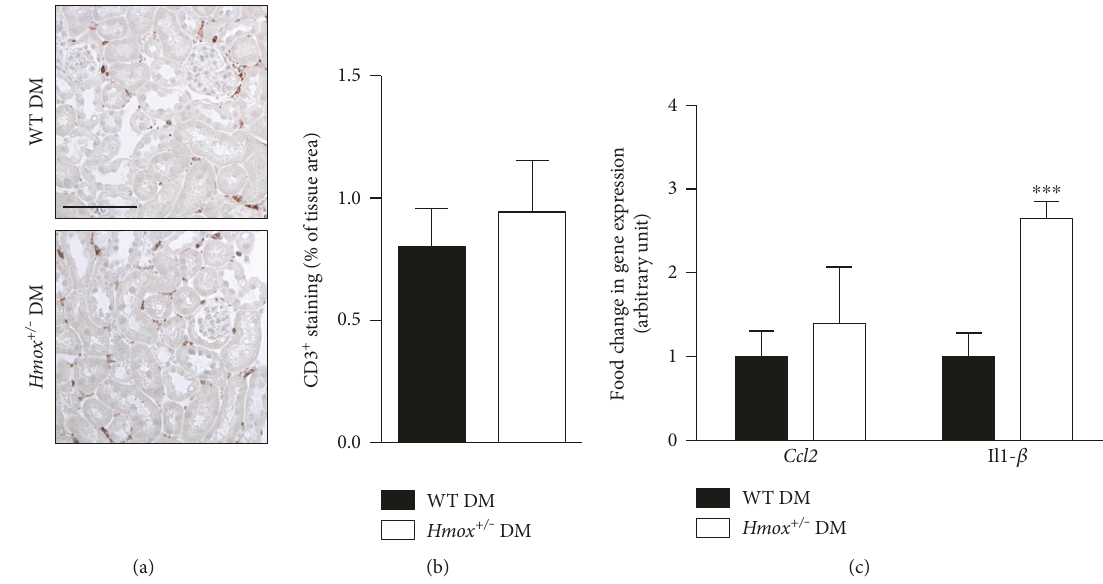
Figure 3: HO-1 does not modulate renal in fl ammatory cell in fi ltration in STZ-induced diabetes. (a) Representative images of CD3 immunohistochemistry (brown) in 20-week-old WT diabetic and Hmox +/ − diabetic mice. Scale bar 50 μ m. (b) Percentage of tissue area stained for CD3. Data represent means ± sem of 5-6 mice. (c) qPCR analysis of Ccl2 and IL-1 β mRNA expression in renal cortex extracts from 20-week-old WT diabetic and Hmox +/ − diabetic mice. Data represent means ± sem of 5-6 mice. ∗∗∗ p < 0 001 , Hmox +/ − DM versus WT